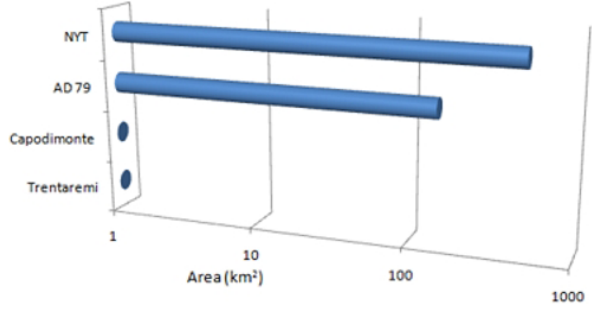
Fig. 5. Areas covered by some of the stratified pyroclastic current deposits of Phlegraean Fields and Vesuvius.